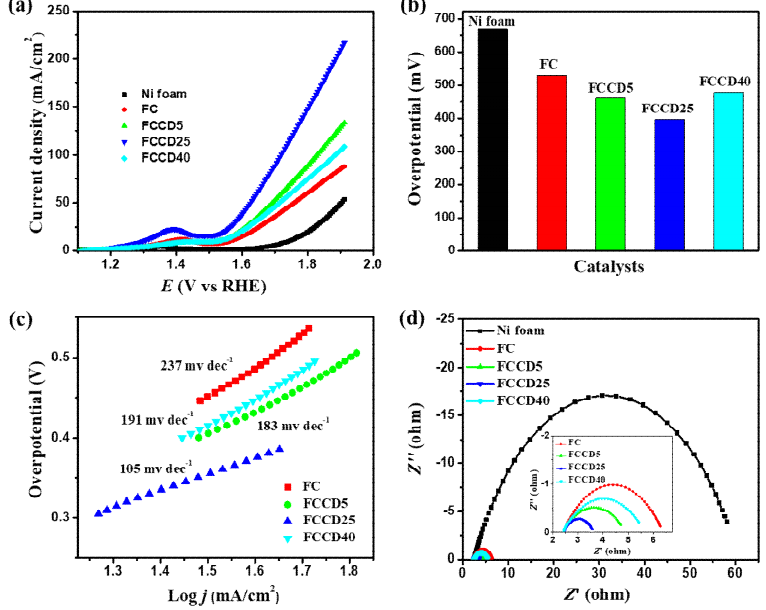
Figure 6. ( a ) OER polarization curves, ( b ) overpotential histogram, ( c ) Tafel plots and ( d ) Nyquist plots of different electrocatalysts.